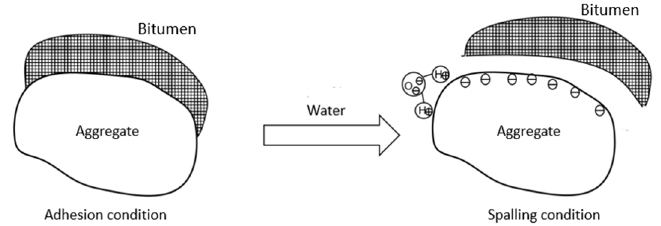
Figure 8. Schematic of bitumen–aggregate spalling.